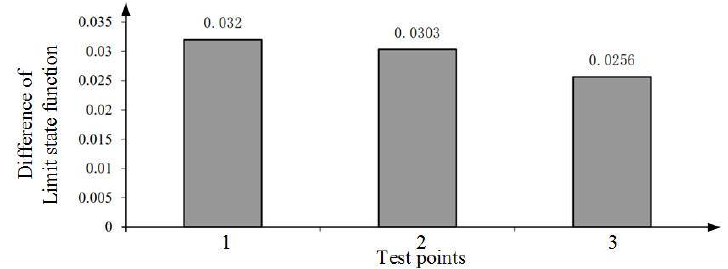
Figure 8. Difference of maximum and minimum of the limit-state function.